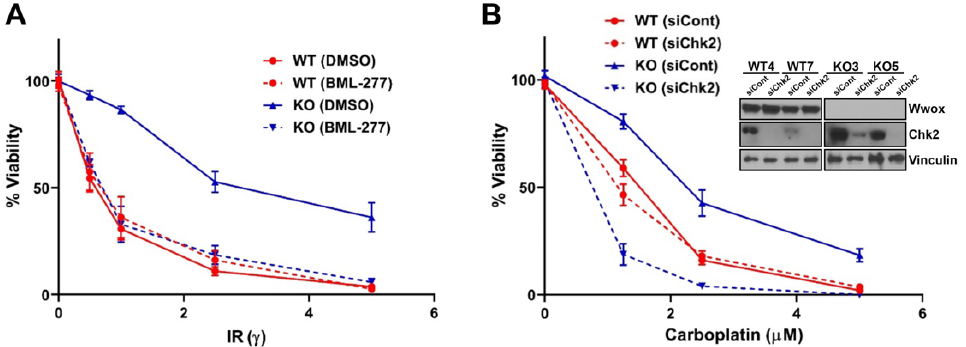
Figure 5. Inhibition of Brca1-associated HR sensitizes Wwox KO MEFs to DNA damaging agents. ( A , B ) Abrogation of Chk2 expression sensitizes Wwox KO MEFs to IR and carboplatin. Line graph depicting % survival of MEFs following exposure to IR or carboplatin with and without Chk2 inhibition by BML-277 treatment ( A ) or silencing ( B ). Wwox-deficient cells (blue solid line) exhibit increased survival vs. WT cells (red solid line). Chk2 inhibition or silencing confers IR and carboplatin sensitivity, respectively, in Wwox KO MEFs (blue dashed line) vs. WT (red dashed line).